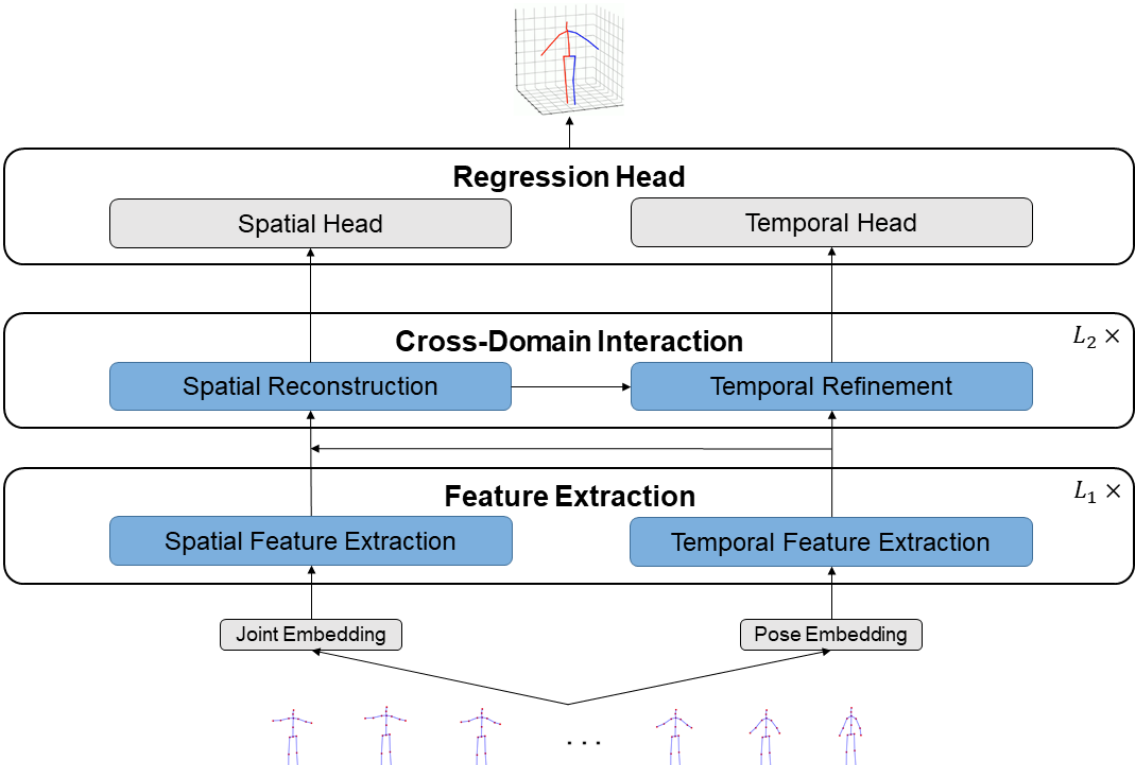
Figure 1. The pipeline of our proposed framework (STFormer) for video 3D human pose estimation. Feature Extraction module for independently extracting features from spatial and temporal domains. The Cross-Domain Interaction module then receives the spatial and temporal features extracted in the previous stage for feature enhancement. Two regression heads to regress the 3D poses in the spatial and temporal domains,